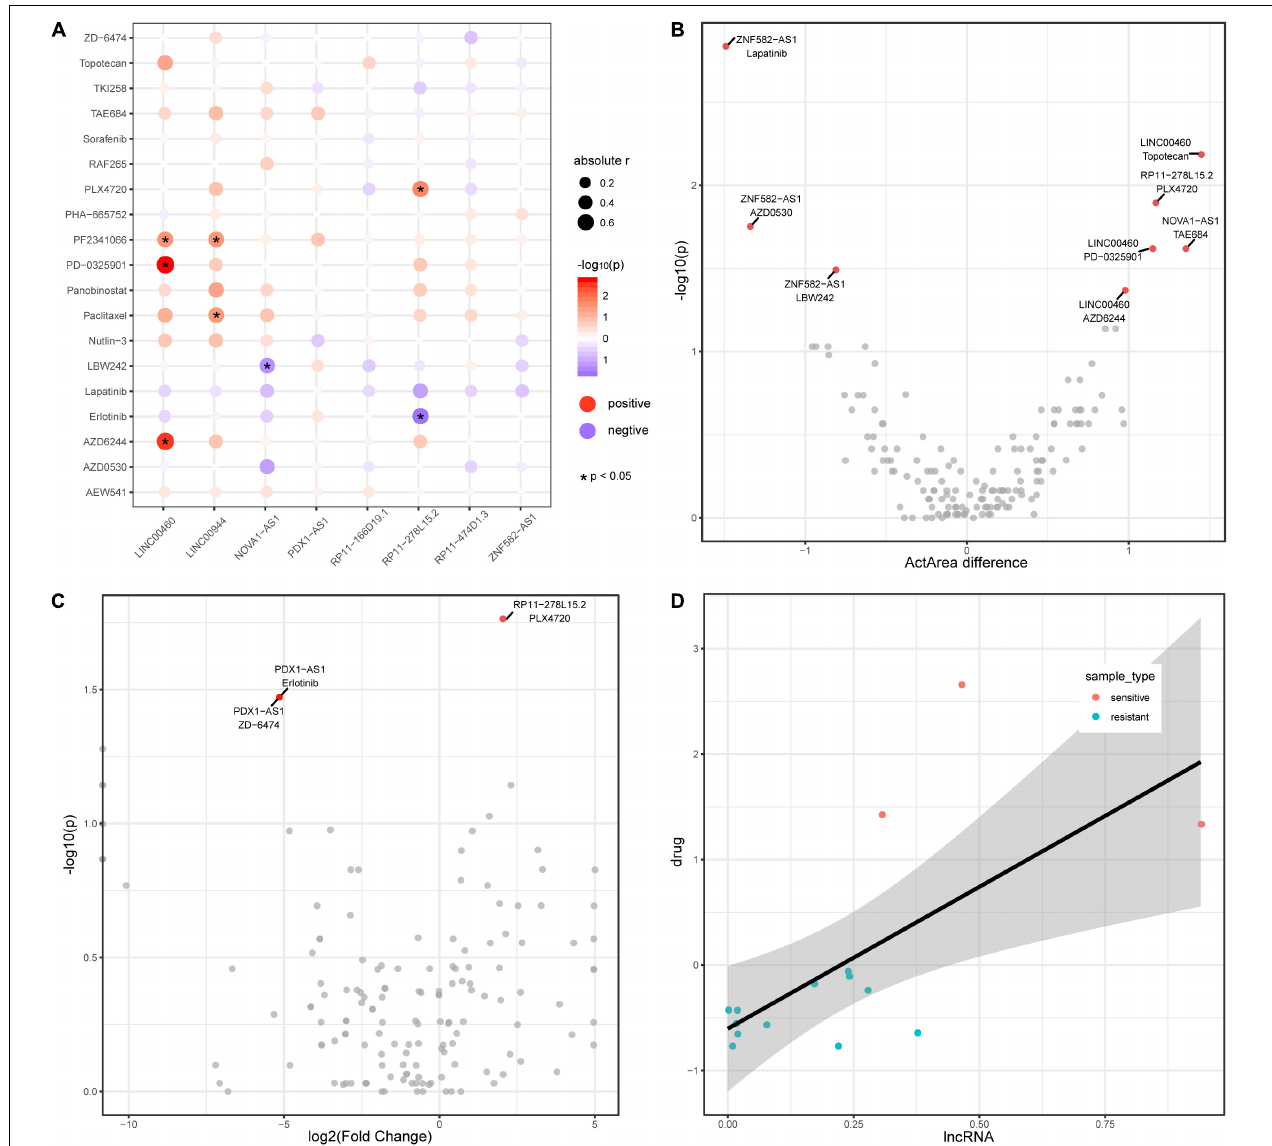
FIGURE 5 | LncRNAs are associated with drug activity in colon cancer. (A) Correlation between lncRNAs ( x -axis) and drug activity ( y -axis, activity area) by Spearman’s rank correlation test. Circle size represents the absolute correlation coefficient between lncRNAs and drugs, red indicates positive correlation, and blue indicates negative correlation. *Denote p < 0.05. (B) Scatter plot of Activity area difference ( x -axis) and –log10( p- value) derived from Wilcoxon rank-sum test (two-tailed, y -axis) for each lncRNA-drug pair. (C) Scatter plot of log2(Fold Change) of lncRNA expression level between cancer and normal samples and -log10( p- value) derived from Wilcoxon rank-sum test (two-tailed, y- axis) for each lncRNA-drug pair. (D) Scatter plot of the expression between lncRNA RP11-278L15.2 and the activity of drug